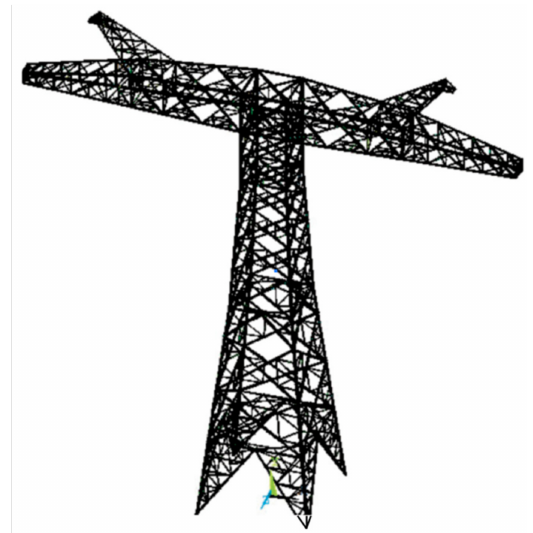
Figure 6. The finite model of the